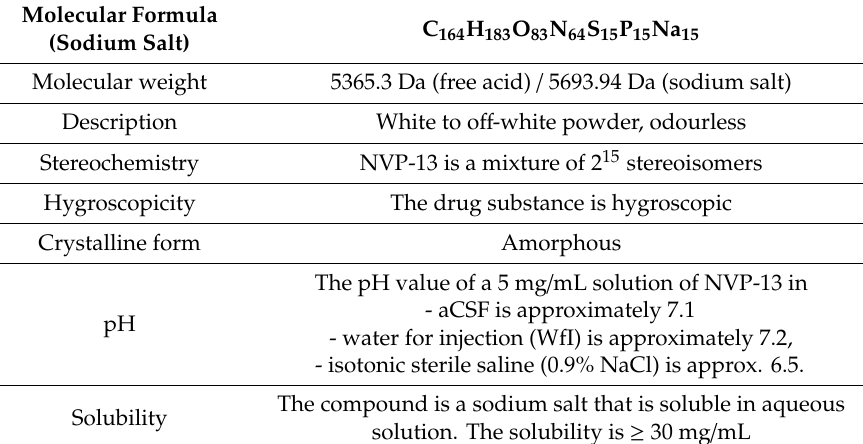
Table 3. Purity, Identity and Quality of X07091 =